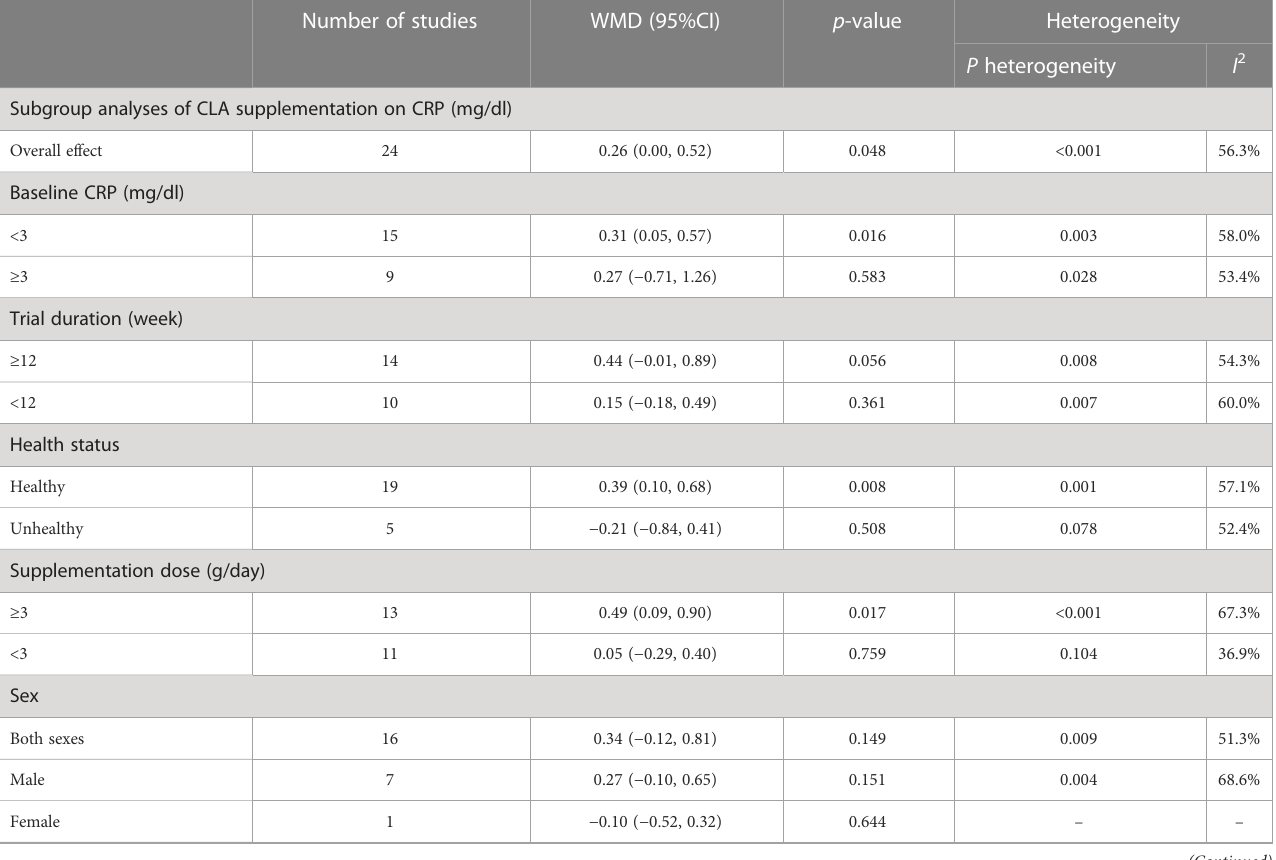
TABLE 3 Subgroup analyses of CLA supplementation on in fl ammatory cytokines and adipokines. Number of studies WMD (95%CI) p -value